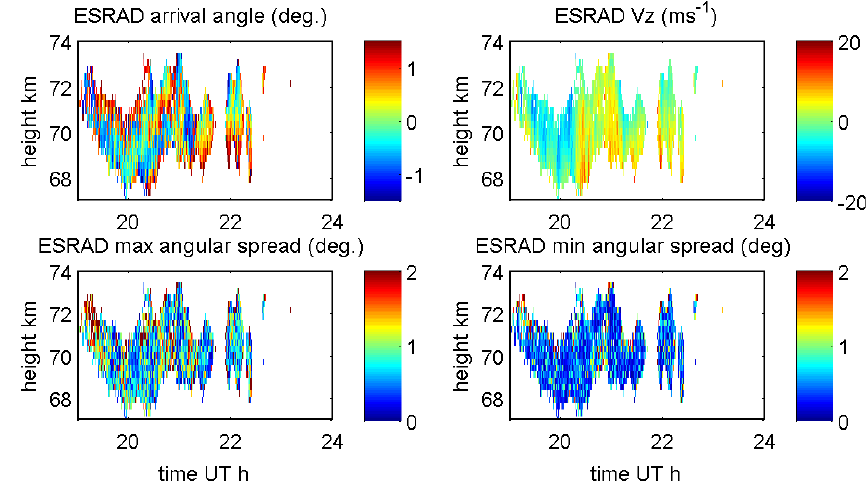
Fig. 12. Results of frequency-domain spatial interferometric analysis of ESRAD data during the evening PMWE event. Top left panel shows mean signal arrival angle (degrees from zenith, positive in the NE or SE sectors, negative in the NW or SW sectors), top right panel shows mean scatterer Doppler, bottom left panel shows angular spread of echoes along the direction where the spread is greatest, bottom right panel shows angular spread of echoes along the direction where the spread is least. Angular spread is the full angular width of the region where echo strength exceeds half of the of the maximum in the cross-spectral amplitude. (All 300-m height resolution, 22-s average data, one profile each 64s).